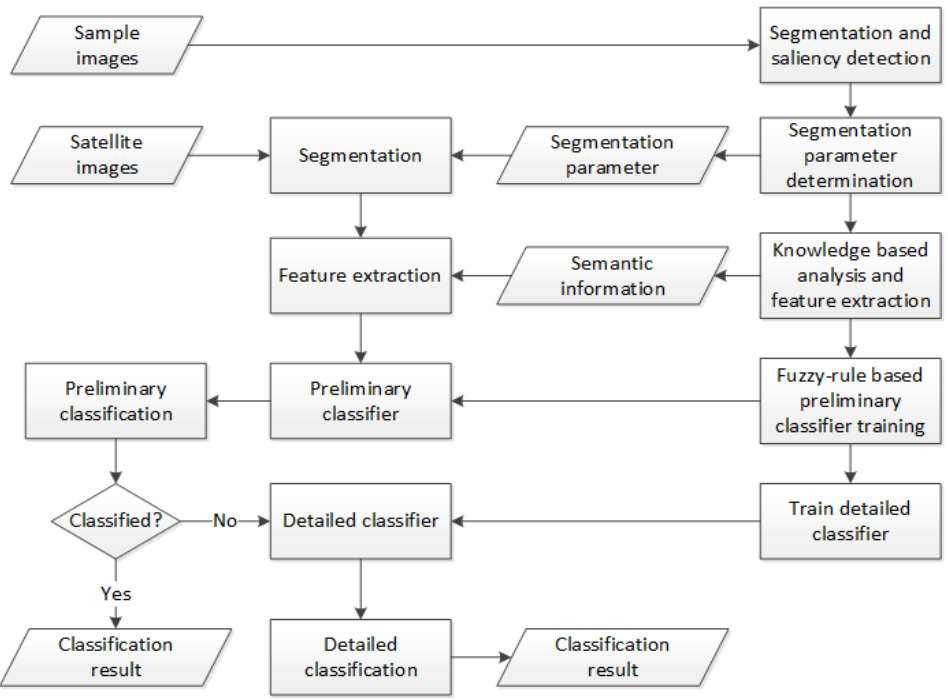
Figure 1. Overall procedure of the proposed method.